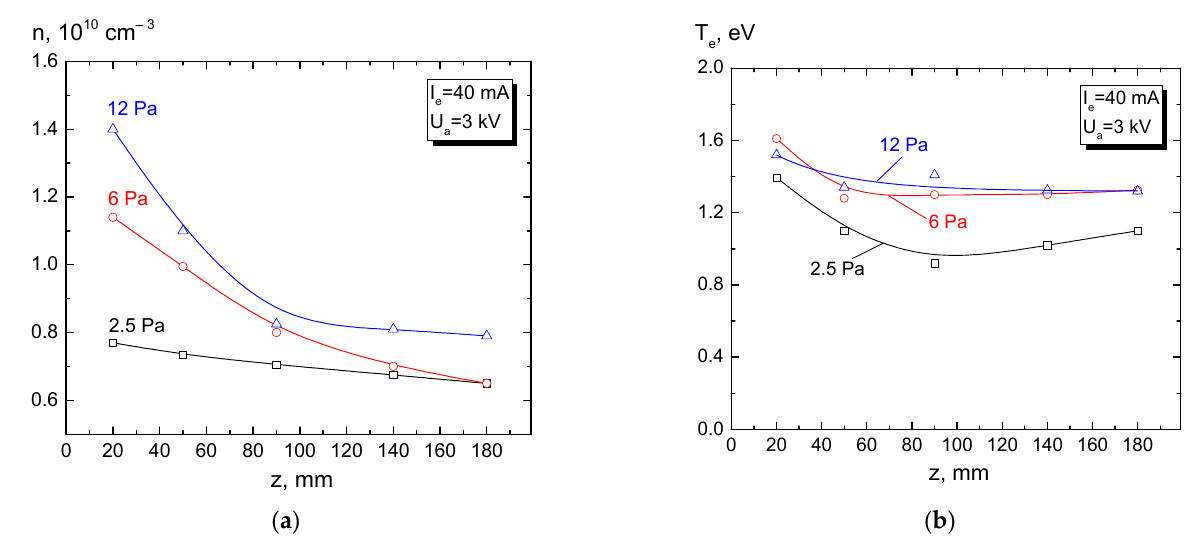
Figure 13. Longitudinal distributions of the concentration ( a ) and temperature ( b ) of the beam plasma generated during a free beam propagation in the chamber. Emission current I e = 40 mA, beam energy U a = 3 keV, argon [110].